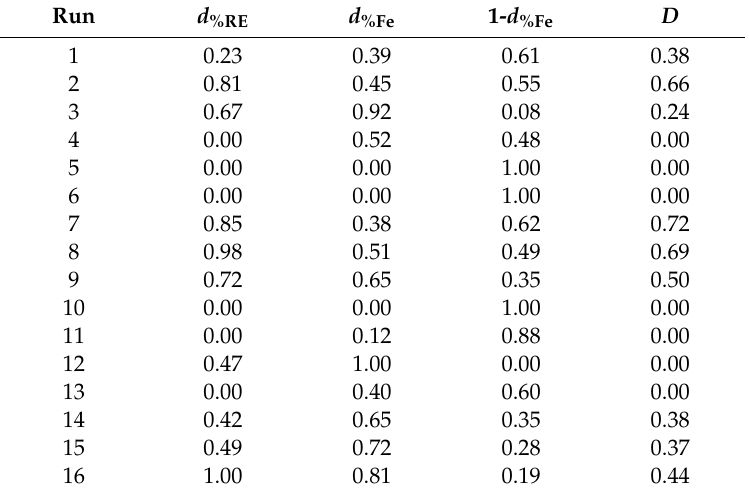
Table 5. Global desirability ( D ) and individual desirability results ( d %RE and d %Fe )—mathematical modeling